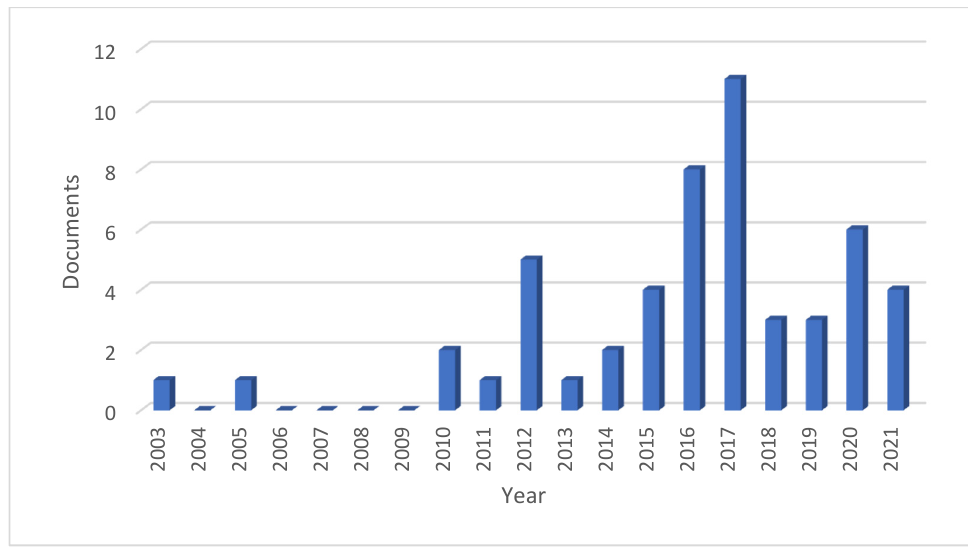
Figure 1. Trend of analyzed publications. Source: our elaboration from Scopus data.